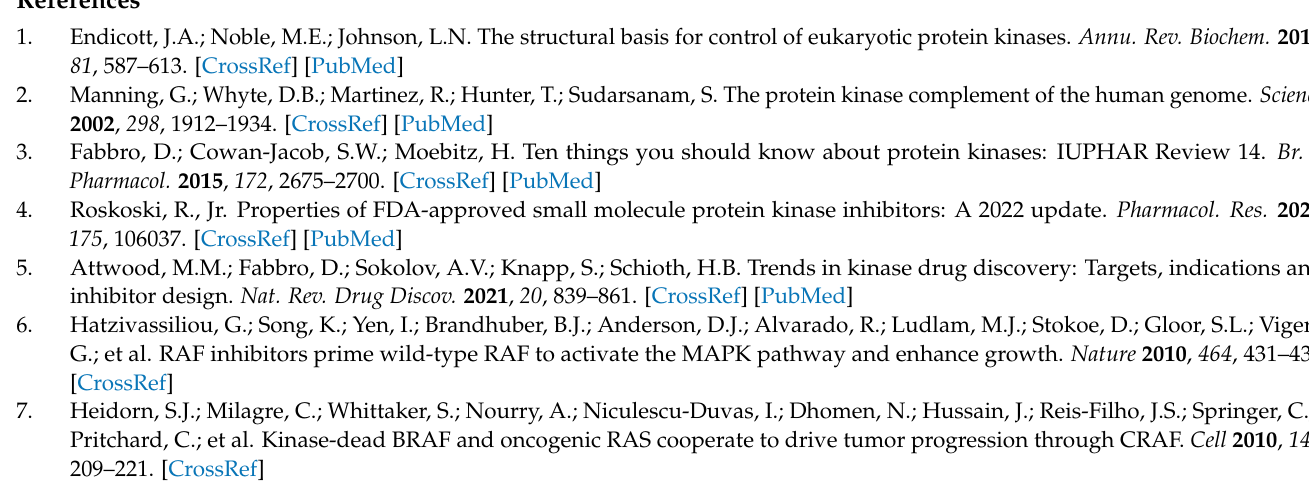
search algorithm. Table S2: Manually curated and reviewed UniProtKB results. Table S3: Grouped list of final 22 unique bifunctional kinases across species/strains from the UniProtKB search